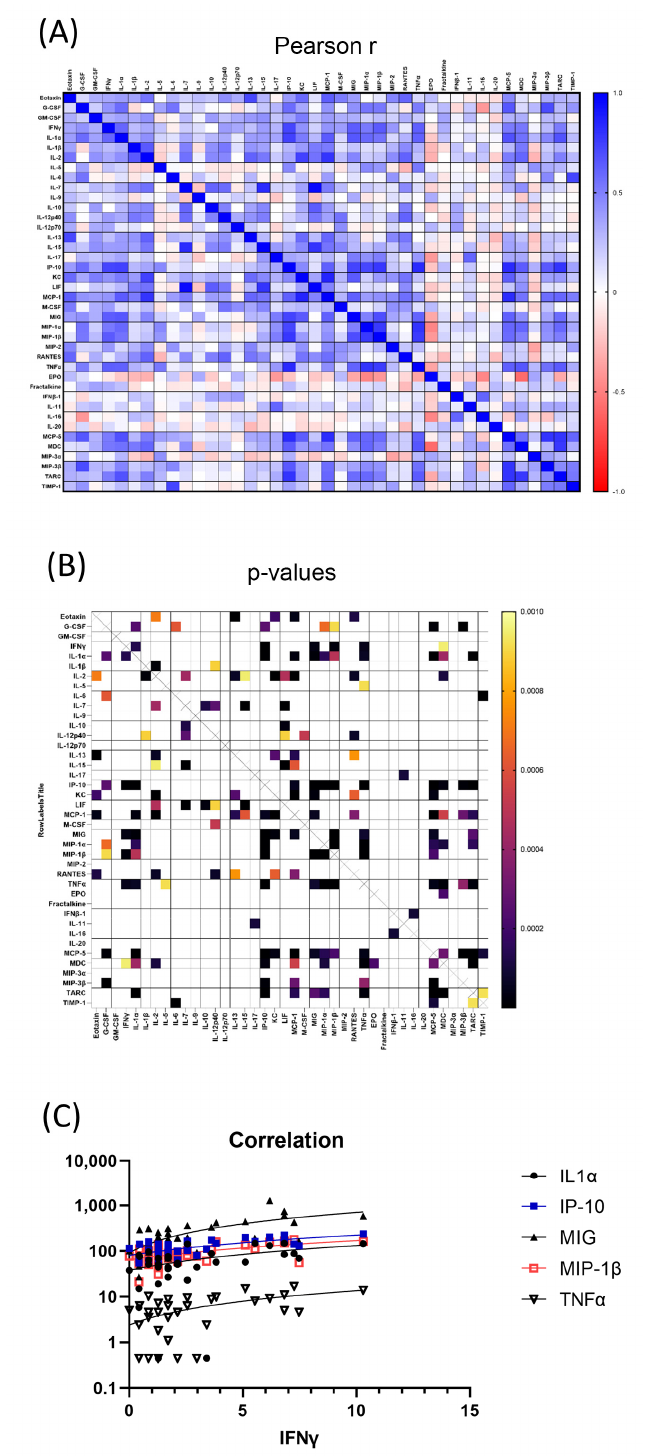
Figure 3. Correlation matrix of serum cytokines. All 40 serum cytokines were compared to each other using Pearson correlation. ( A ) Pearson r value heatmap of all serum cytokine combinations. Legend was shown on the right. r values closer to 1 or − 1 means positively or negatively correlated. R values closer to 0 means no correlation. ( B ) p value heatmap of all serum cytokine combinations. Legend was shown on the right. Only p values < 0.001 were shown to simplify the view. ( C ) Serum cytokines that were significantly correlated with serum IFN γ . All their p values were smaller than 0.001. All cytokines’ concentration unit was